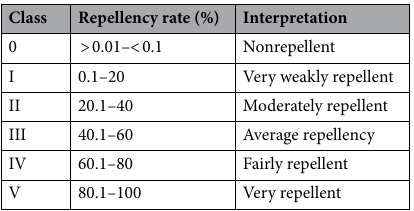
Table 1. Scale used to estimate the class for mean percentage